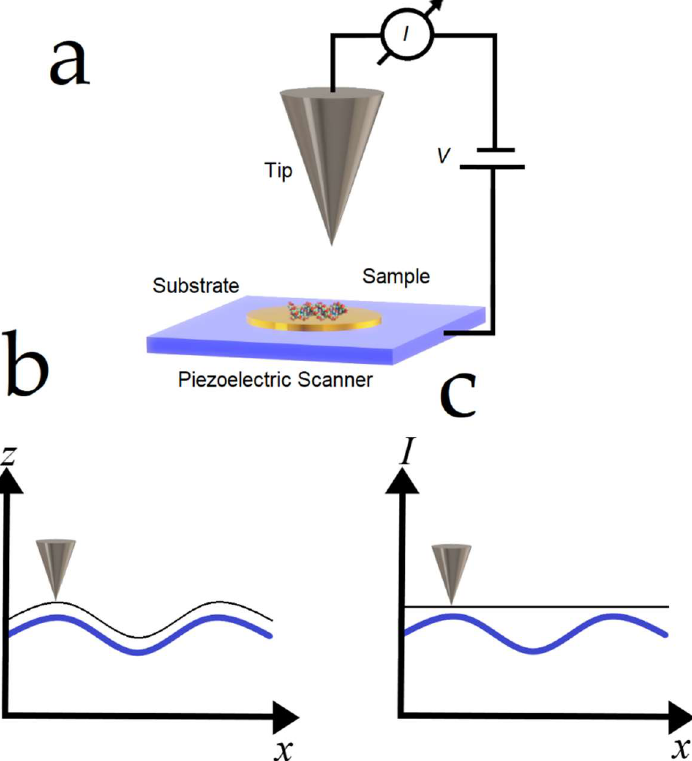
Figure 1. Schematic illustration of basic components of STM. STM collects the tunneling current between the tip apex and the sample when a bias voltage is applied ( a ). Relative, precise, lateral sample-lever movement is achieved by mounting either the sample or the tip on the end of a piezoelectric scanner. The tip is the physical sensing probe, a fine wire cut or etched to form a very sharp tip. The ideal tips have a single atom at the apex because they can provide images at atomic resolution. Generic STM operating modes in constant-current ( b ) and constant-height ( c ).